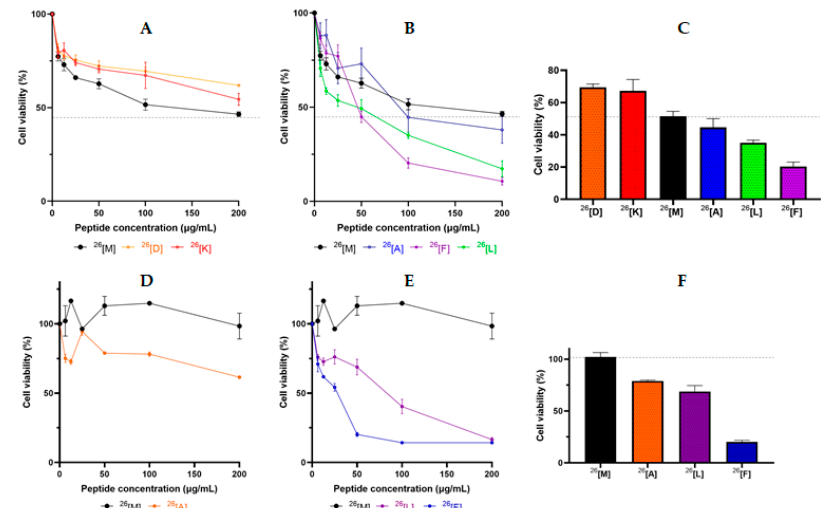
Figure 1. Cytotoxic e ff ect of 26 [M] (LfcinB (20-30) 2 ) and its analogs against HTB-132 ( A , B ), and MCF-7 ( D , E ) cell lines. Breast cancer cells were treated with the peptide for 24 h at 37 ◦ C. Comparative cytotoxic e ff ect of peptides at 100 µ g / mL against HTB-132 ( C ) and 50 µ g / mL MCF-7 ( F ) cells. The data in A – C represent the mean ± SE ( n = 3). The data in D – F represent the mean ± SE (three independent experiments with n = 4 each). Statistically significant differences were found between the cytotoxic effect exhibited by the modified dimeric peptides and that of the unmodified peptide 26 [M]. (ANOVA, Sidak’s multiple comparisons test was used, p ≤ 0.05).